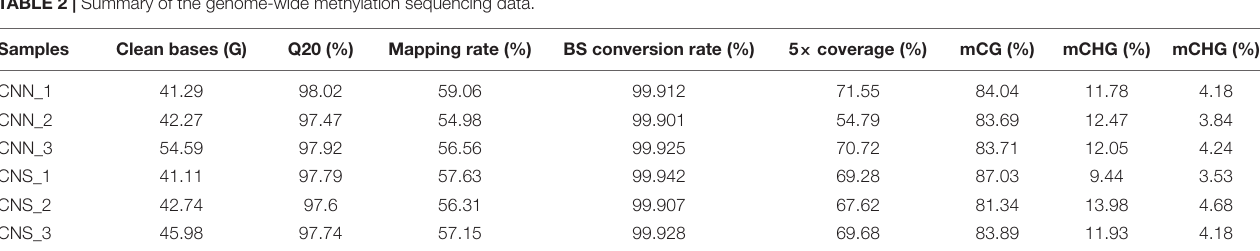
FIGURE 3 | (A) Heatmap for the 790 DEGs between the two populations. Rows are genes, and columns are abalone derived from two populations. (B) Scatter plot showing the top 20 enriched KEGG pathways, resulting from the DEGs between the two populations. TABLE 2 | Summary of the genome-wide methylation sequencing